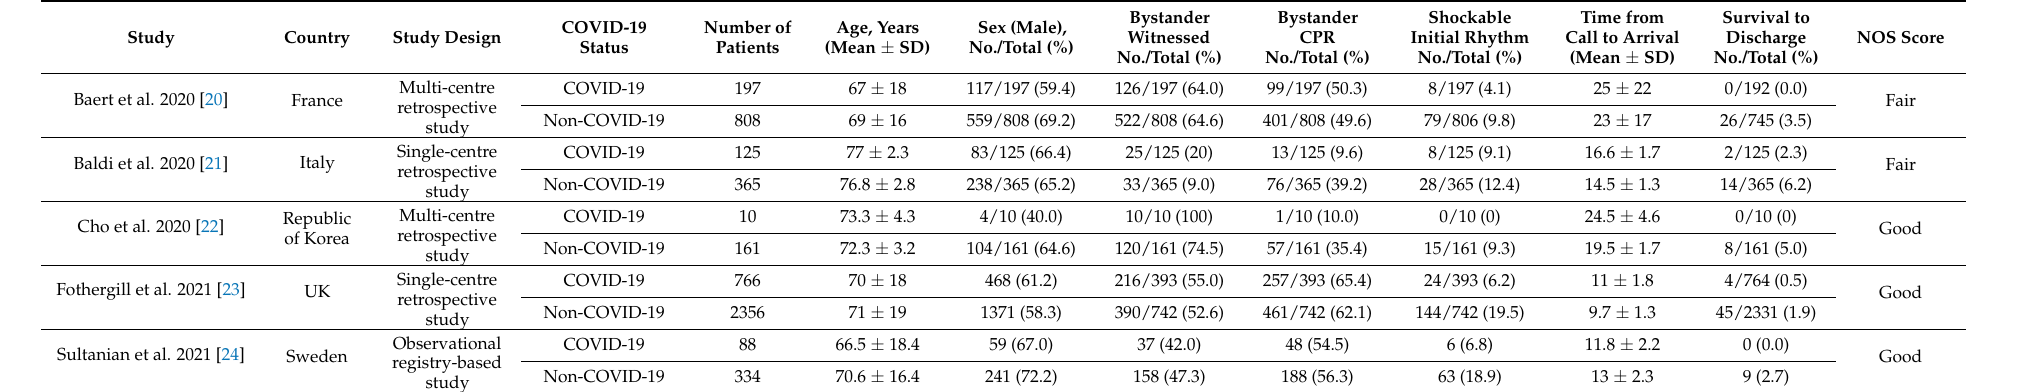
Table 1. Characteristics between COVID-19 and non-COVID-19 patients in the included